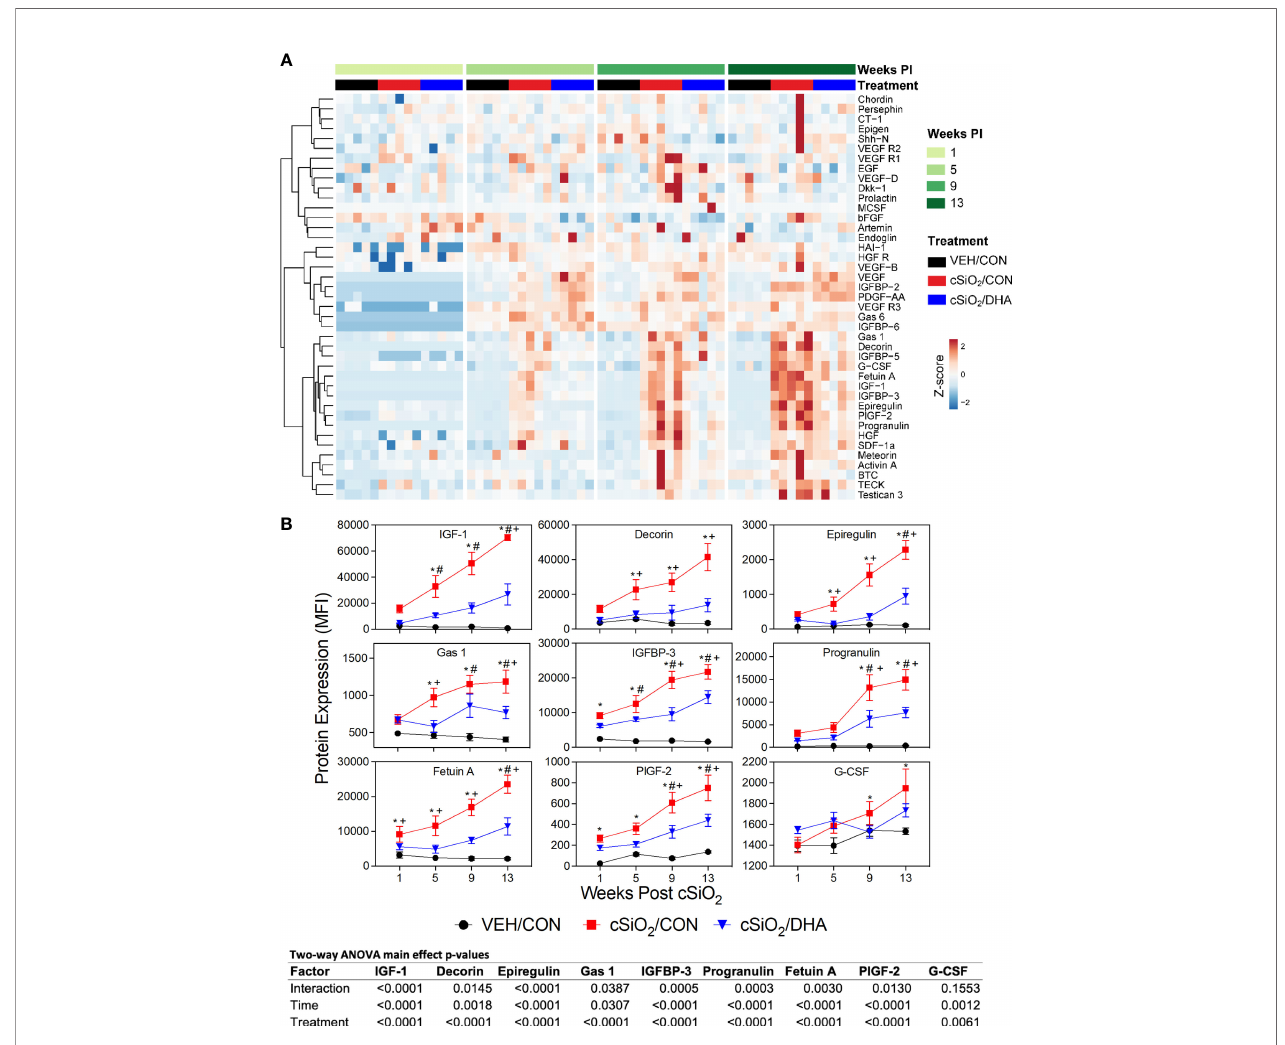
FIGURE 6 | cSiO 2 -induced growth factor expression in BALF suppressed by intake of DHA diet. (A) Heat maps with unsupervised clustering (Euclidian distance method) depict unit variance-scaled mean fl uorescent intensities (MFIs) for growth factor expression measured in the BALF. Black, red and blue bars above heat maps indicate the VEH/CON, cSiO 2 /CON, and cSiO 2 /DHA groups, respectively, at 1, 5, 9, or 13 wk PI. Scale bar values re fl ect the range of variance-stabilized MFIs, which were centered across rows. (B) Effect of DHA diet on cSiO 2 induction of selected growth factors in BALF over time. MFIs were obtained using the microarray panel for VEH- or cSiO 2 -exposed mice fed CON or DHA diets. Data for select proteins were analyzed by two-way ANOVA for main effects of timepoint and treatment with post-hoc Tukey HSD multiple comparison tests to determine effects of treatment at each time point. Data are mean±SEM. Main effect p-values for timepoint, treatment, and the interaction of these factors are shown below the plots. Symbols indicate signi fi cant differences (p ≤ 0.05) as follows: * for cSiO 2 /CON vs. VEH/ CON; # for cSiO 2 /DHA vs. VEH/CON; and + for cSiO 2 /CON vs. cSiO 2